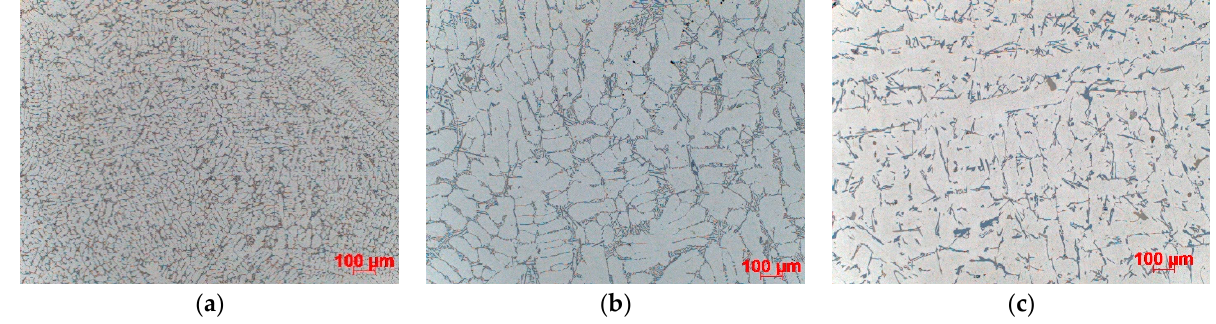
Figure 5. Dispersion of dendritic structure in casting made in Sand No. 2, etched with HF, 100 × magnification: ( a ) die, ( b ) ablation, ( c ) sand mould.